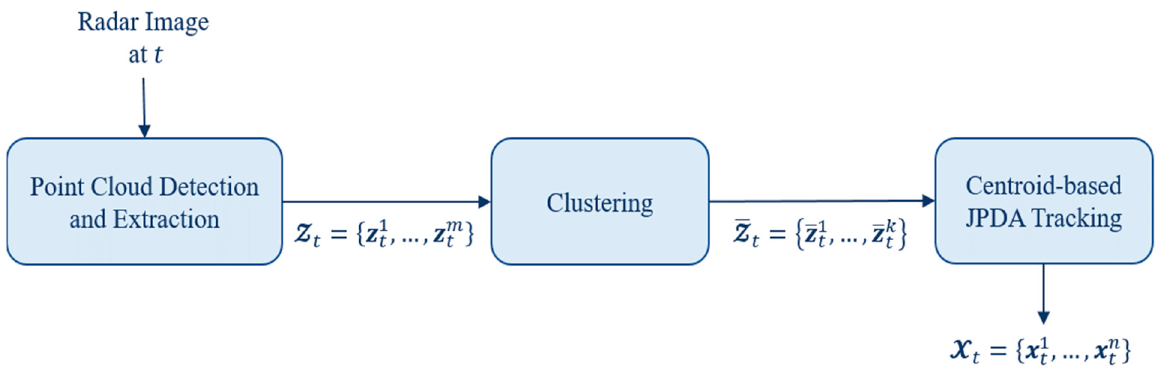
Figure 3. Illustration of blocks in the processing chain at observation step t